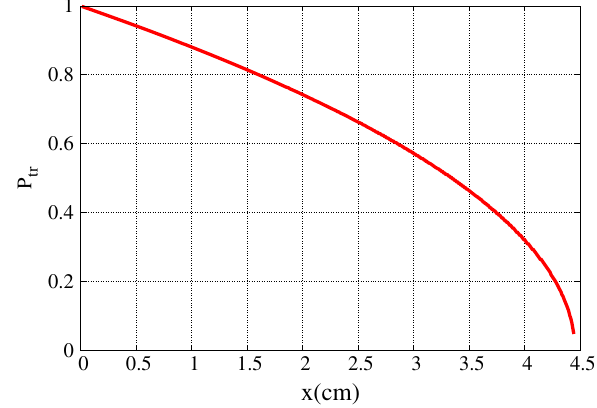
FIG. 7. Cosine of the loss-cone angle, P position in the midplane of the vacuum chamber. The trapping probability increases toward the center of the chamber as long as the adiabaticity condition is